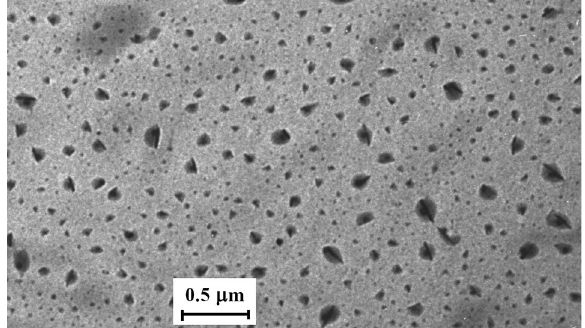
Fig. 7 Example of TEM image of aerosol particles generated in laboratory with the temperature of diluting gas equal to the room temperature